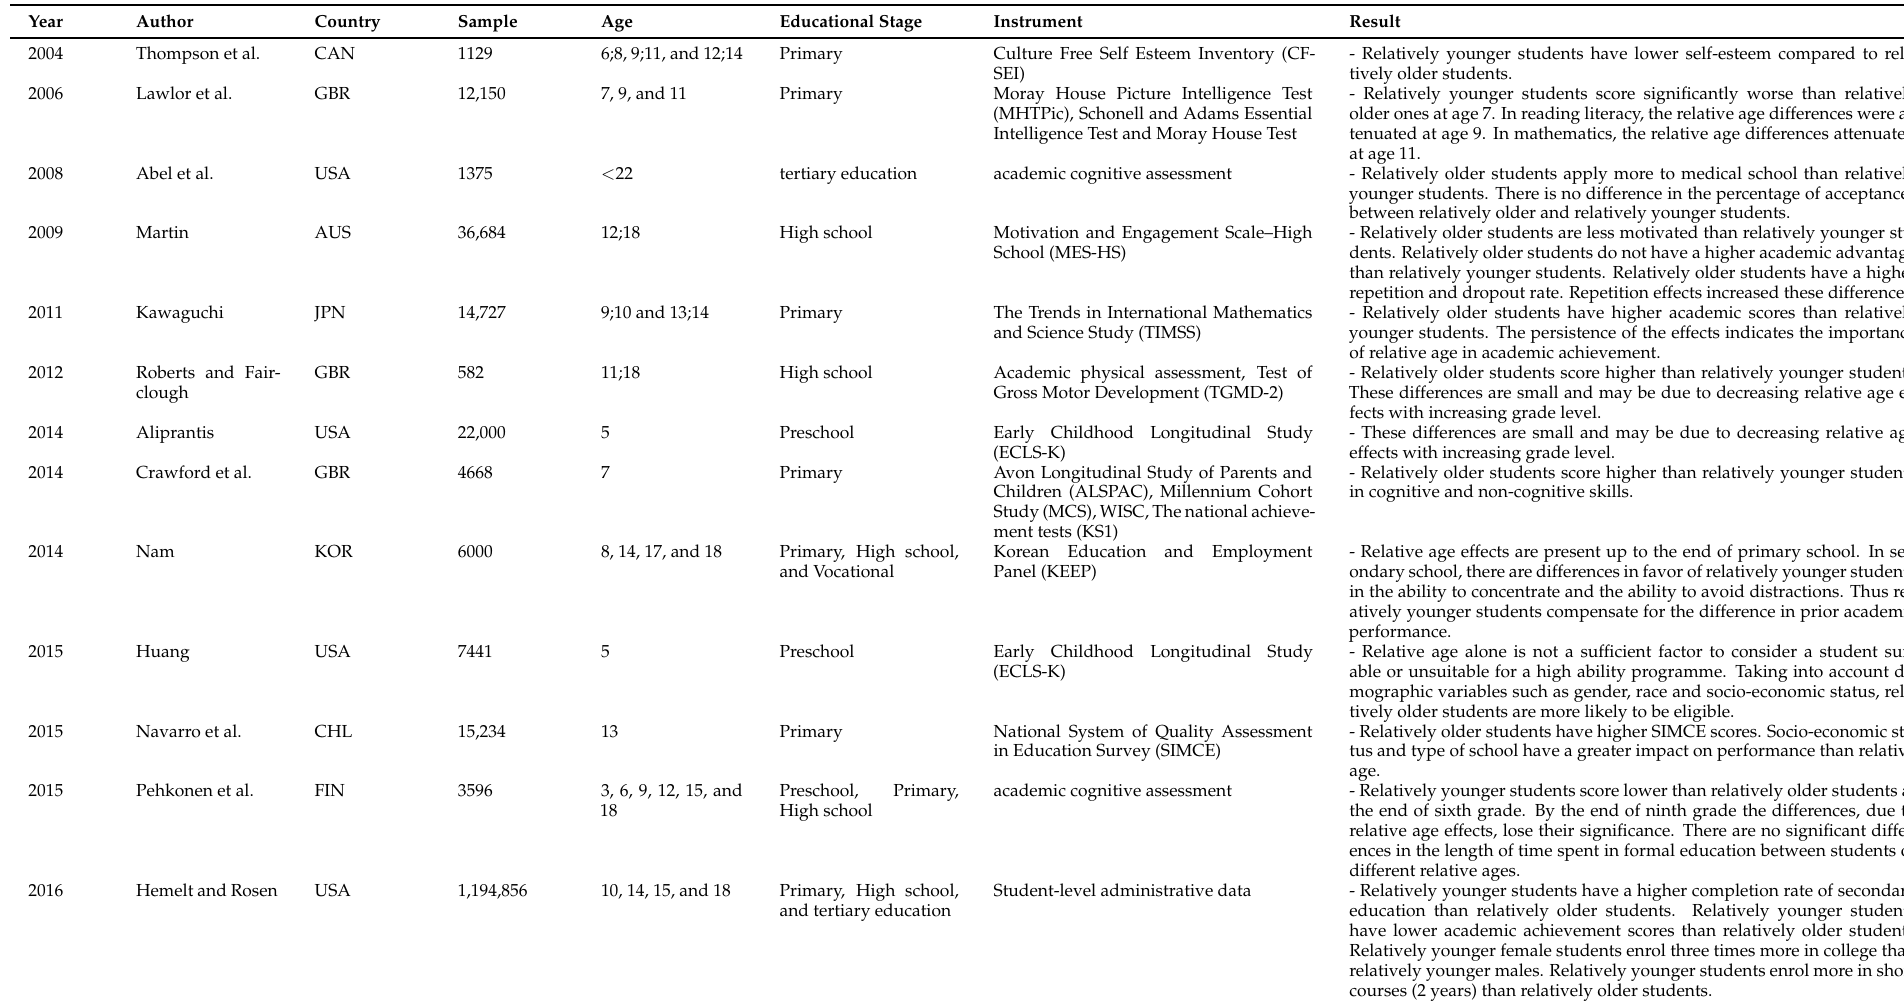
Table 1. Scientific articles taken into account in the systematic review (part